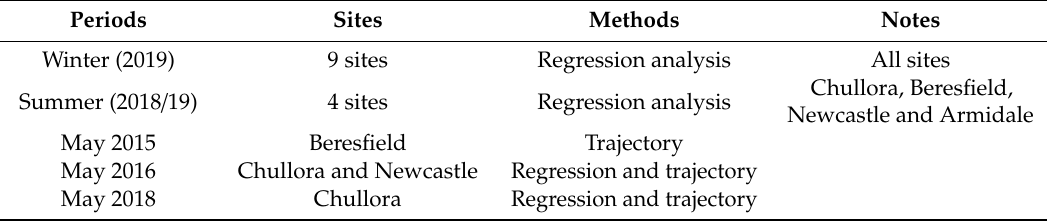
Table 2. Winter and summer BC study and 3 case studies of BC from Hazardous Reduction Burnings